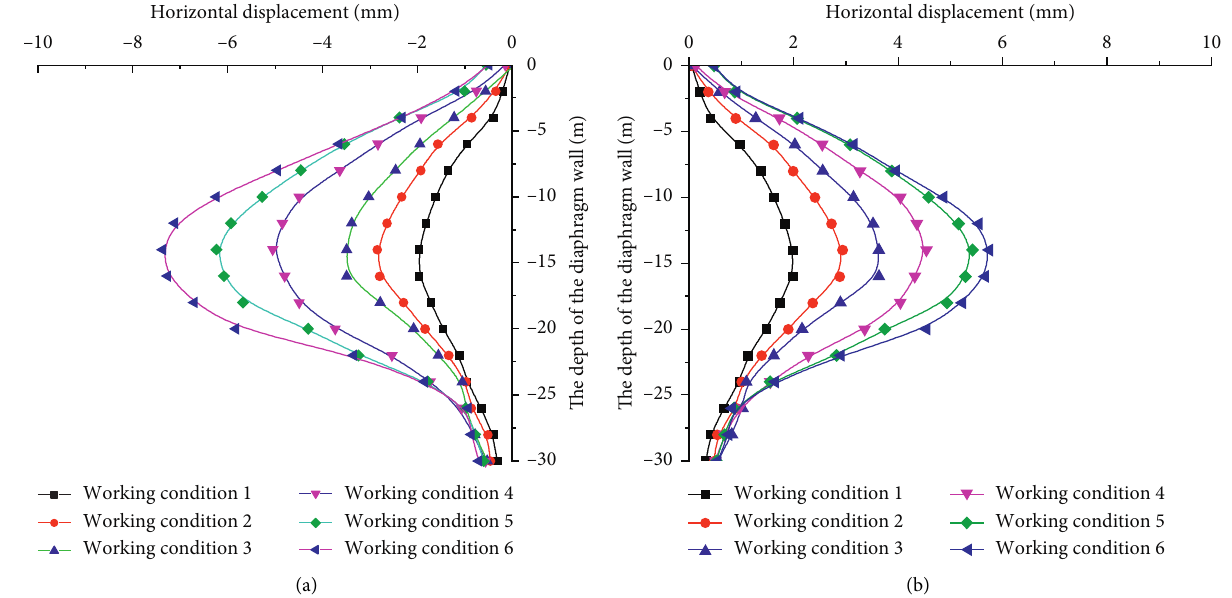
Figure 14: Horizontal displacement curves at different monitoring points. (a) Measuring point 20. (b) Measuring point 4.